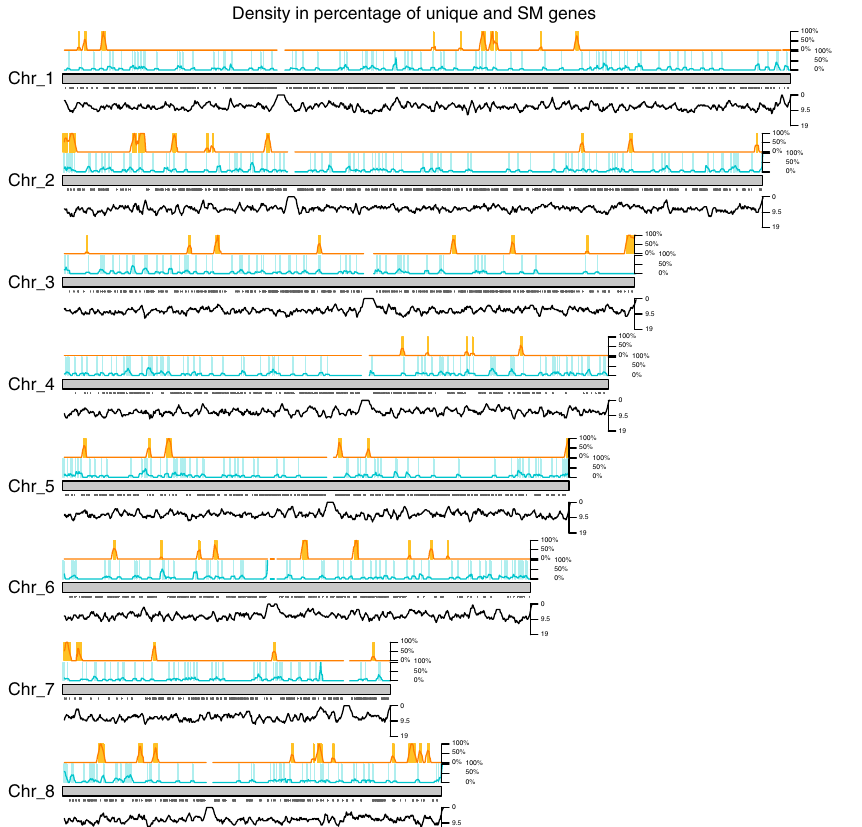
Fig. 3 Location of species unique and secondary metabolite genes in the A. oryzae genome. The gray bars represent the A. oryzae genome. Above the chromosome the species-speci fi c (turquoise) and secondary metabolite genes (orange) are mapped to the genome, each line represents a gene. The curve shows the percentage of the density calculated from the total number of genes within 30 kbp in steps of 5 kb. Below the genome, the core genes are mapped by the gray dots and the density of the total number of genes is shown by the black graph (with a window of 30